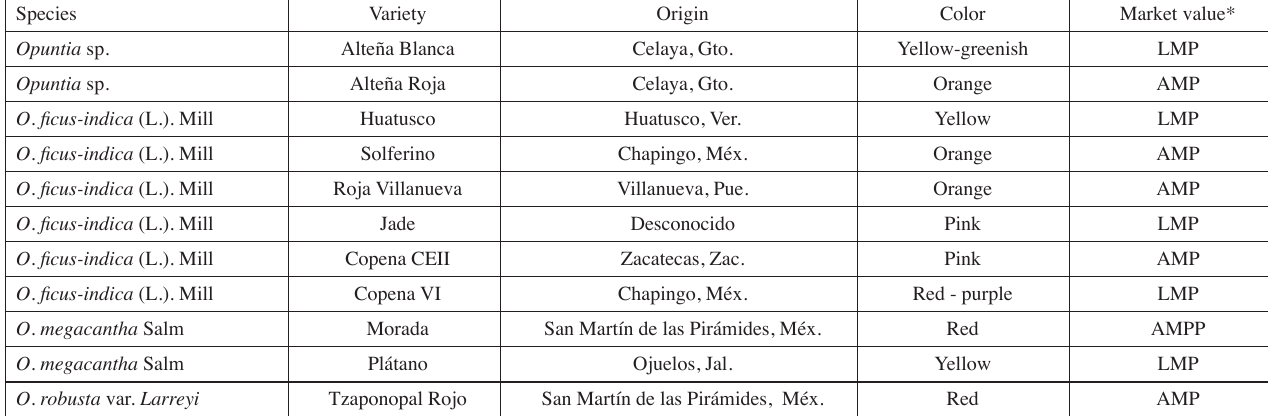
Tab. 1: Descriptions of 11 varieties and species of prickly pear ( Opuntia sp.) grown at the Universidad Autónoma Chapingo Experimental Station, Chapingo, Mexico. Species Variety Opuntia sp. Opuntia sp.